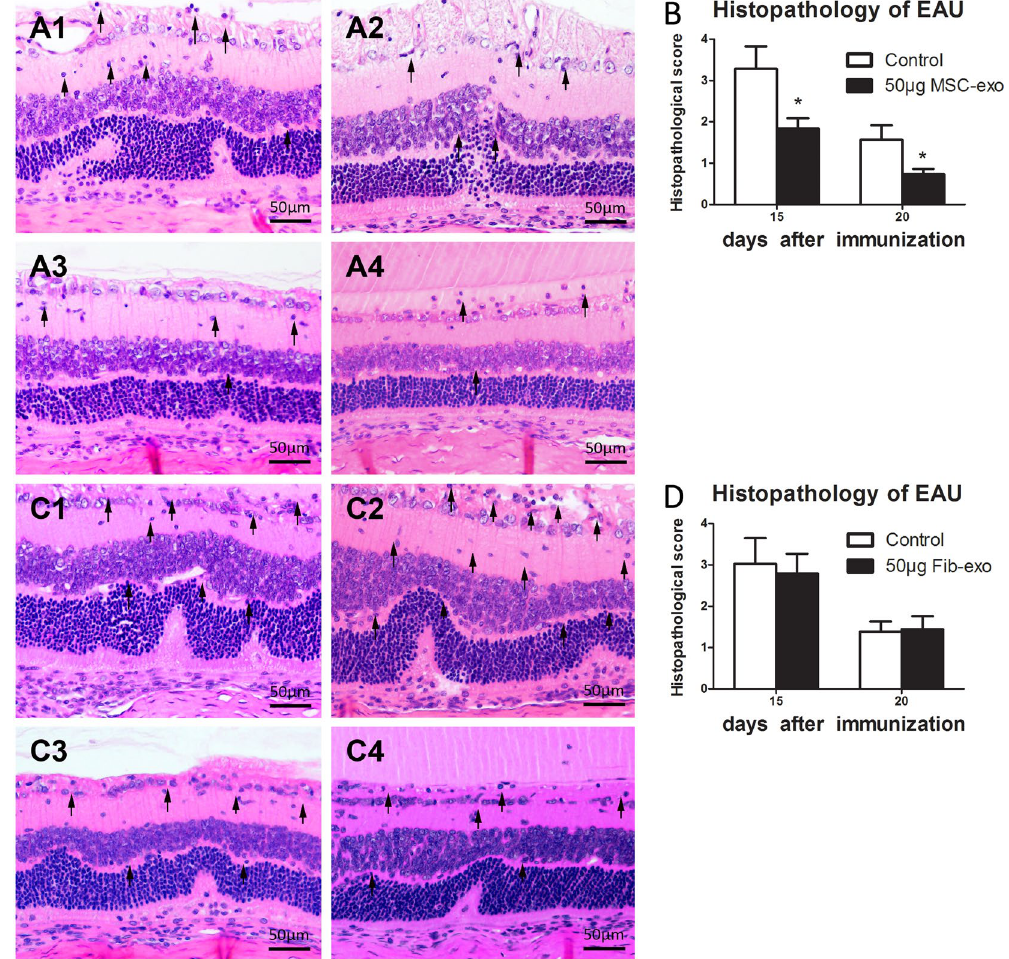
Figure 3. Histological assessment of the retina in EAU. Sections of the retina were stained with hematoxylin and eosin, and evaluated for histological damage on 15 and 20 days post immunization. Representative H&E staining images of PBS (A1 and C1, 15 days; B1 and B2 20 days), MSC-exo (A3, 15 days; A4, 20 days), and FIB- exo (B3, 15 days; B4, 20 days) treated groups are shown. Results are expressed quantitatively as histopathological scores (C and D). Values are expressed as the mean ± SD of six rats (12 eyes) per group. * P <